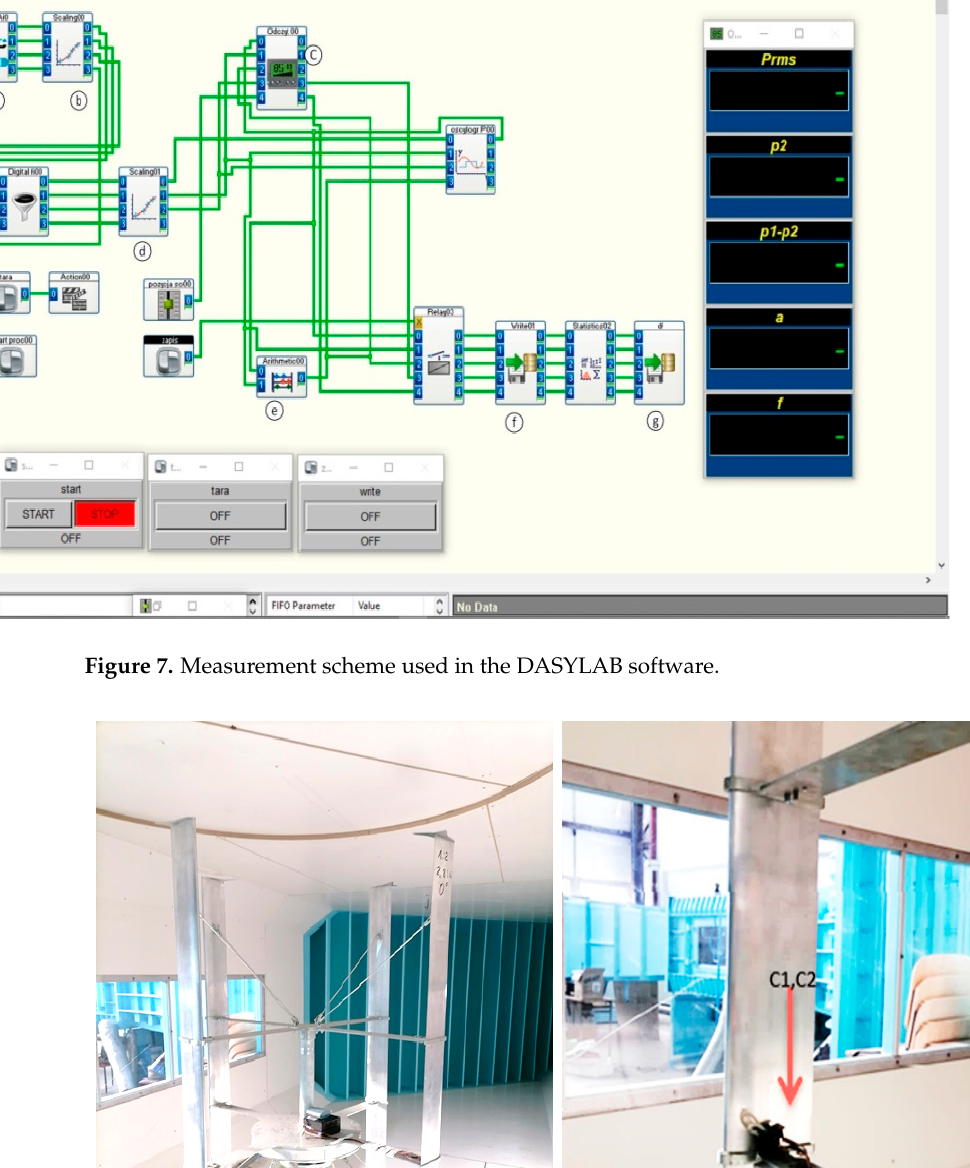
Figure 7. Measurement scheme used in the DASYLAB software.